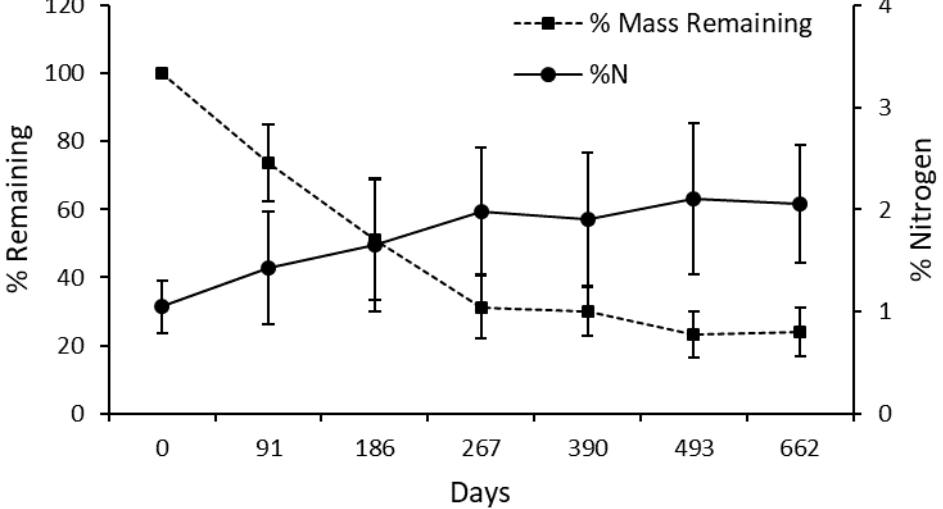
Figure 6. Percent of remaining dry mass and %N in the litter bag experiment conducted for 22 months from February 2012 – December 2013. Table 7. Estimated N flux rates for the major terms in the N budget for the Cell 1B marsh. Indented terms and figures in parentheses were estimated separately but contribute to the primary term above.